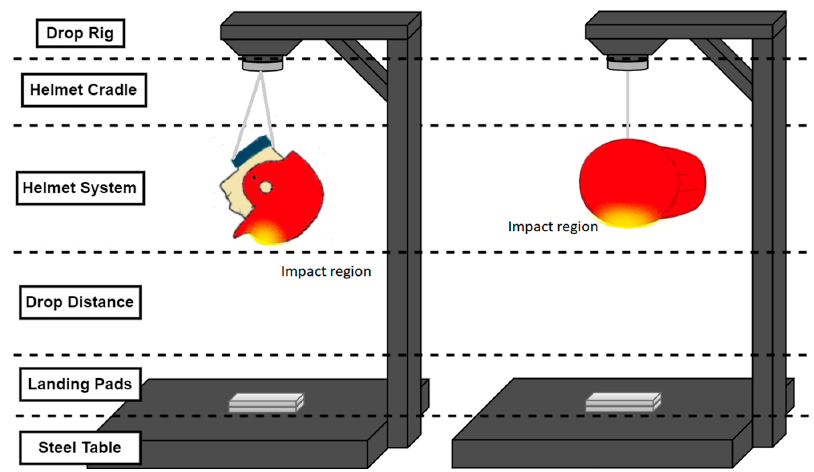
Figure 3. Schematic of the experimental setup depicting cradle to suspend the headform for frontal impact ( left ) and side impact ( right ).